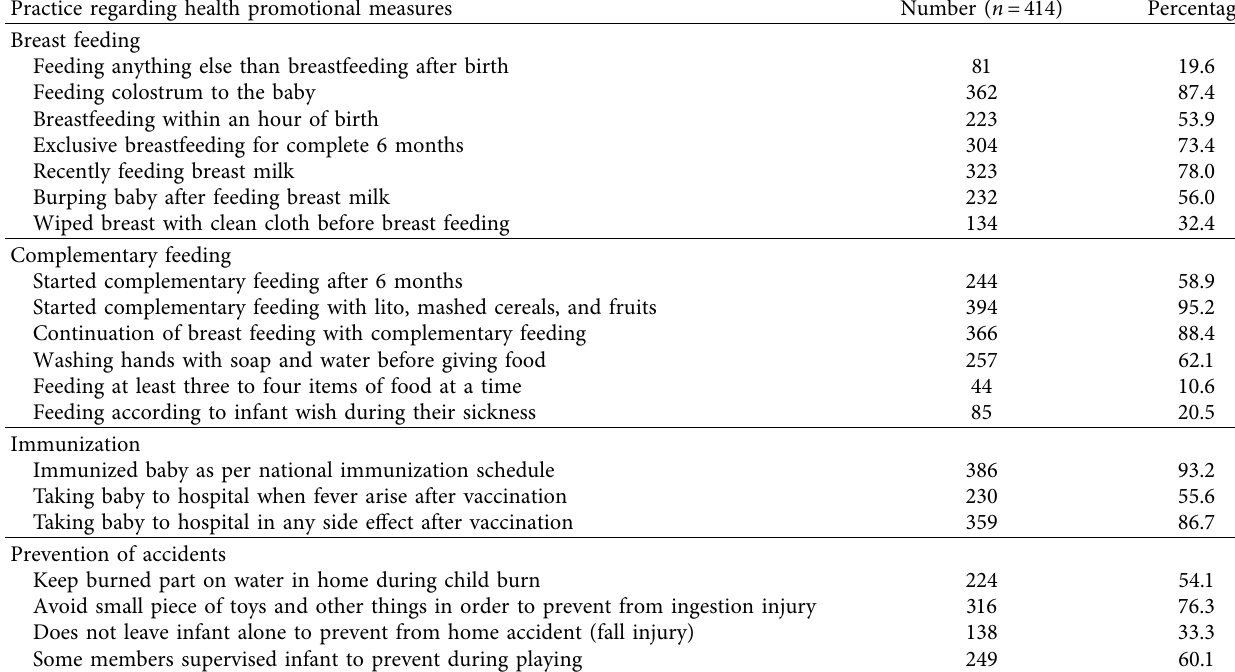
Table 2: Mothers’ practice regarding health promotional measure of infant with age group 6–12 months in a tertiary hospital of Nepal. Practice regarding health promotional measures Feeding anything else than breastfeeding after birth